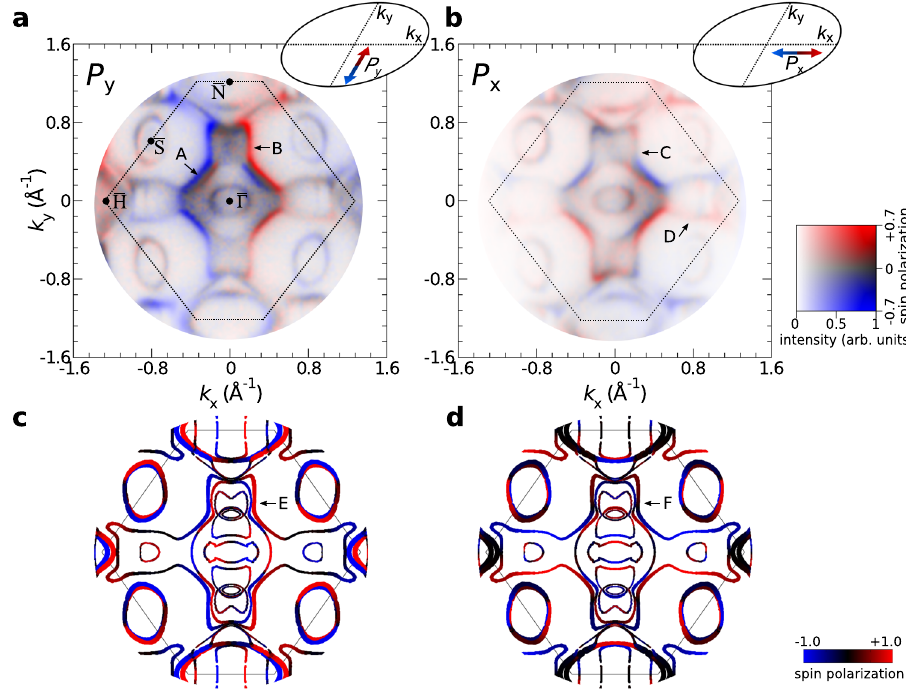
Fig. 2 Full spin texture. a , b Measured spin-resolved Fermi surface (FS) of W(110). Measured intensities and spin polarization are encoded using the displayed 2D colour code, where the spin polarization P y ( a ) or P x ( b ) is indicated by red and blue colours, respectively, and the colour saturation encodes the intensity. c , d Theoretical spin-resolved FS of W(110). Colours indicate the in-plane spin component along the k y ( c ) or k x ( d ) direction. Letters A – F indicate distinguished features in the FS contour with high/low spin polarization as a guide to the eye.